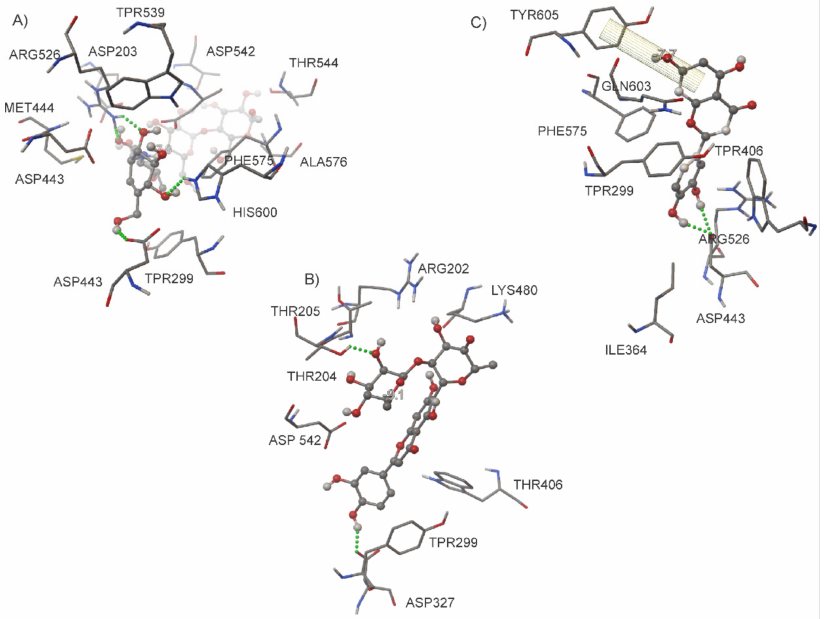
Figure 5. Hydrogen bonds and π - π interaction between the active site of maltase-glucoamylase and ( A ) acarbose (ACA), ( B ) maysin (MAY), and ( C ) luteolin